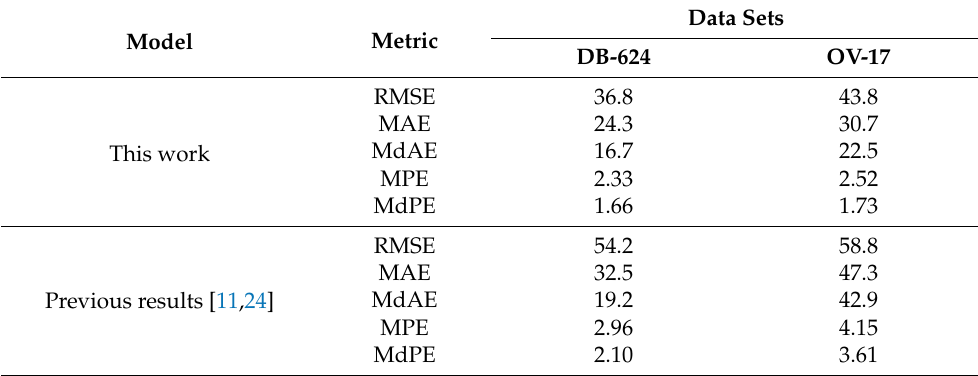
Table 3. The accuracy of retention index prediction for mid-polar stationary